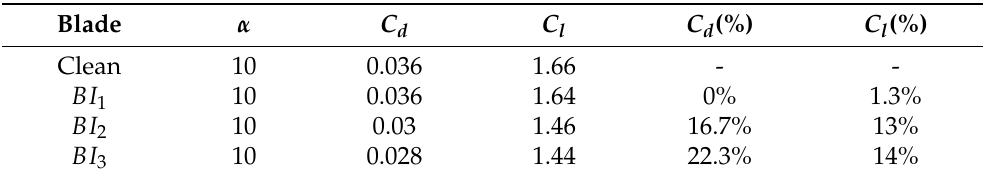
Table 4. Comparison of the leading edge in three different erosion’s depth for the drag coefficient C d and the lift coefficient C l . Last two columns show the percentage difference relative to the clean blade ( C d (%) and C l